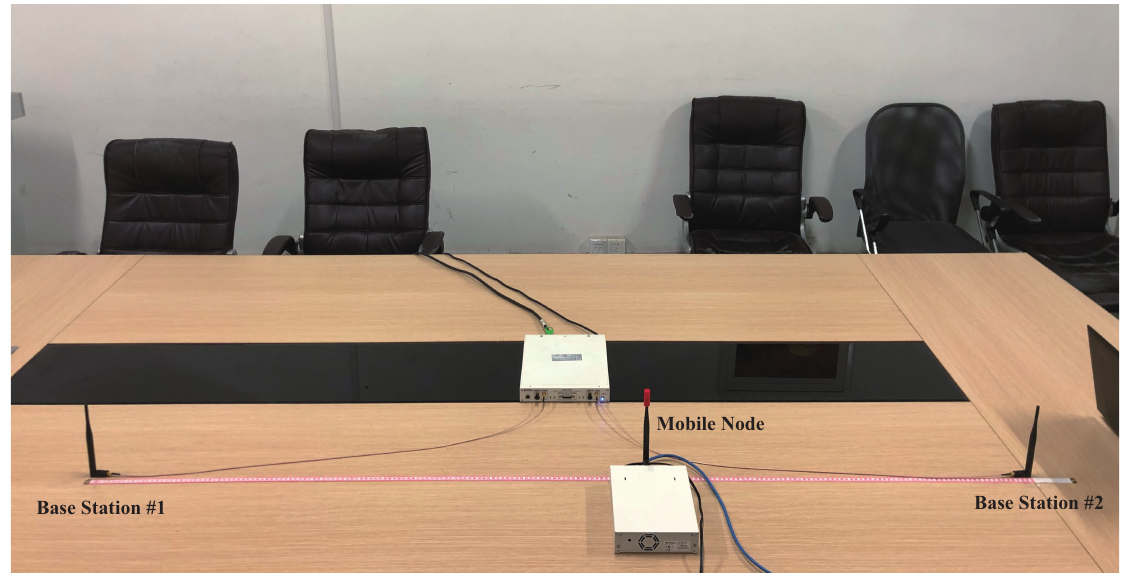
Figure 12. 1D position sensing experimental setup to validate the proposed method.